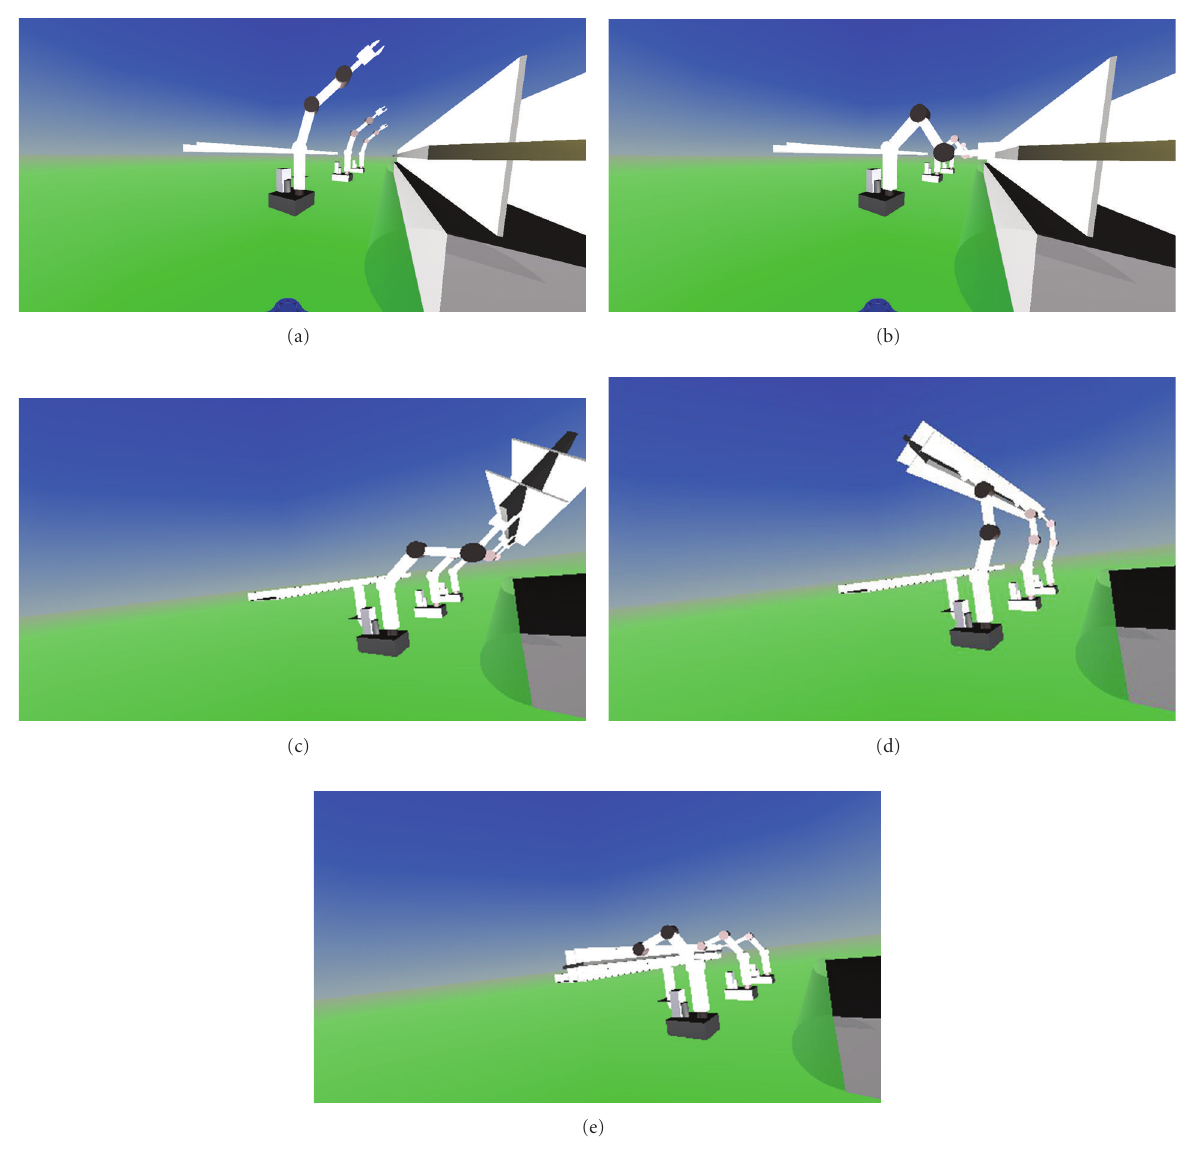
Figure 8: The 3D virtual